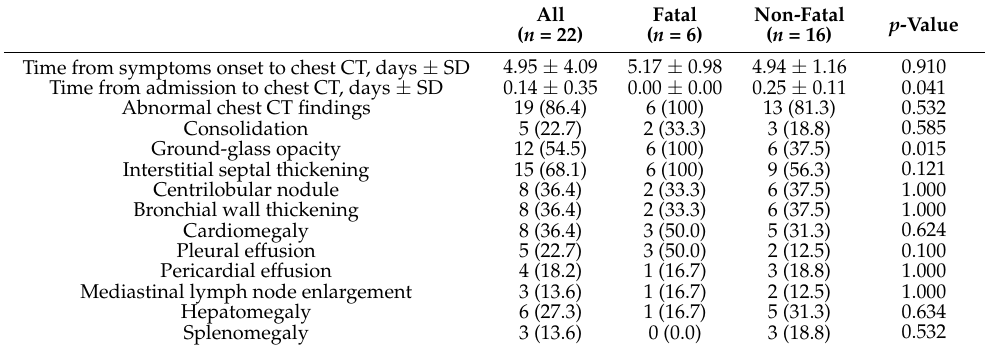
Table 1. Chest CT findings in fatal and non-fatal hospitalized patients with SFTS.